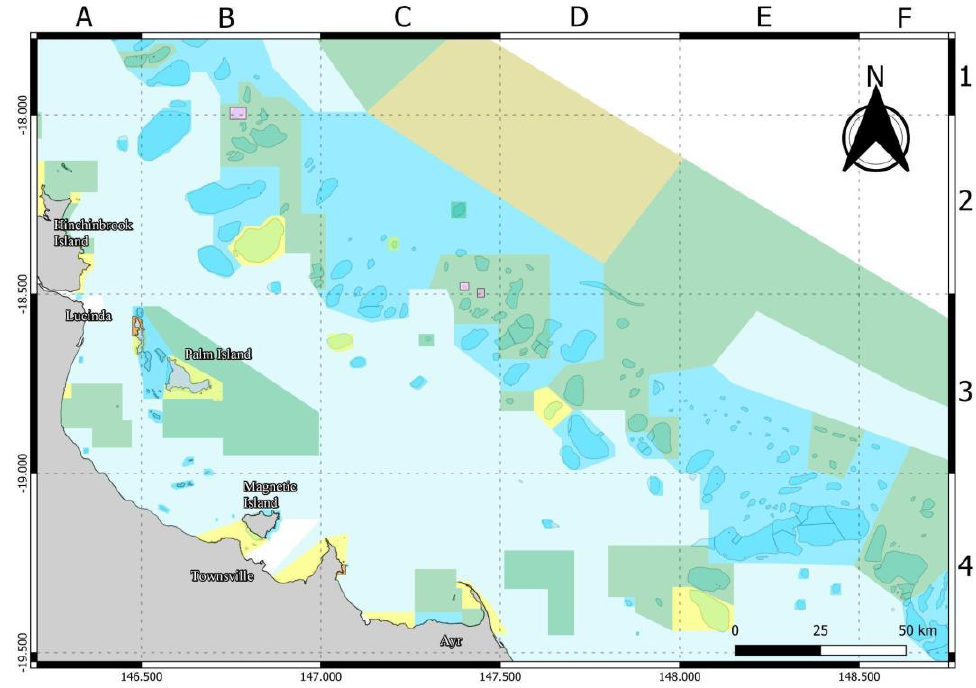
Figure 1. Extent of North Queensland Bluewater Invitational (NQBI) spearfishing competition and the survey location areas within the Great Barrier Reef Marine Park. The blue and yellow zones are waters where spearfishing is permitted and green zones are closed to spearfishing. Grid letters A-F and numbers 1-4 are used to label locations of NQBI competition.